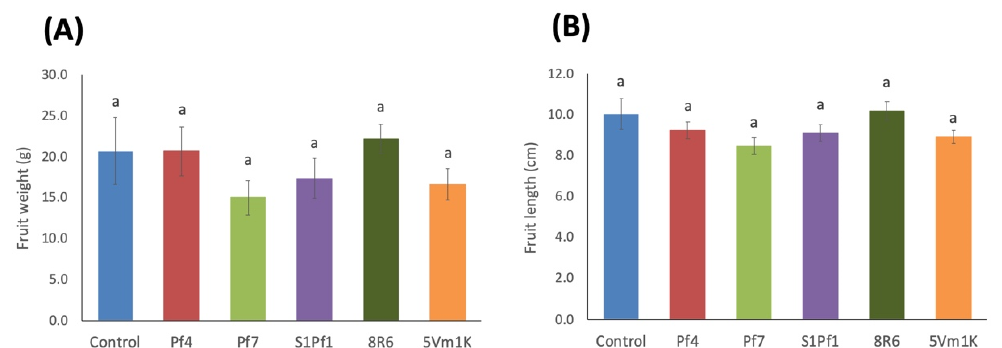
Figure 2. Effects of the five PGPB strains on the zucchini fruit weight ( A ) and length ( B ). Different letters upon the bars in the histograms indicate significant differences among the treatments according to the Kruskal–Wallis test followed by the Dunn test ( p < 0.05).